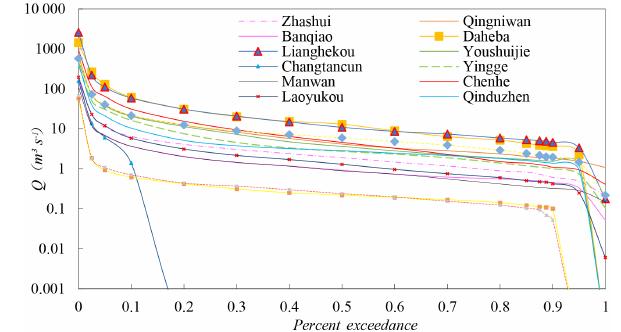
Figure 3. Flow duration curves for the fifteen catchments.